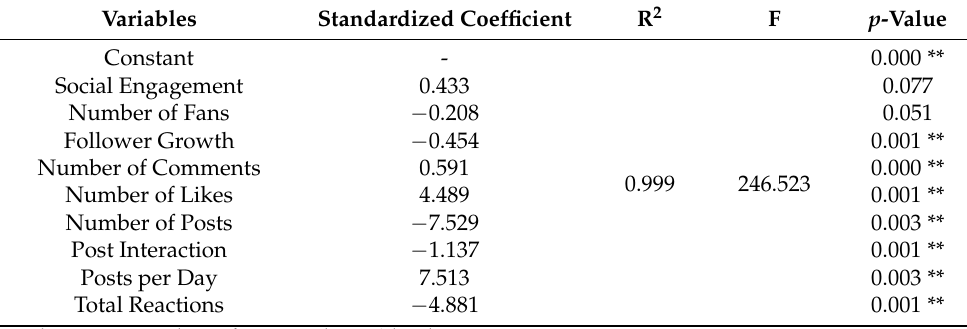
Table 6. Impact of social media analytics on CPNs websites’ organic traffic costs.